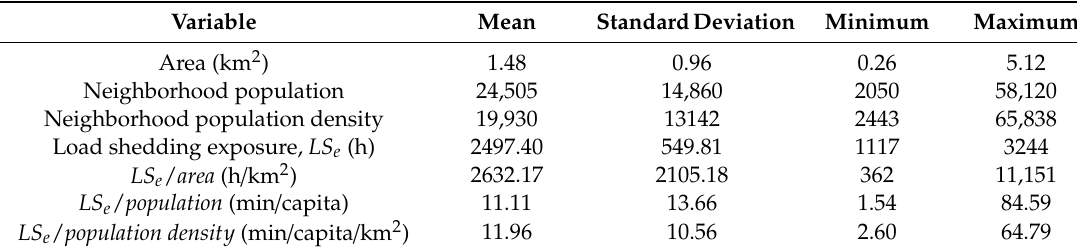
Table 4. Descriptive statistics of the study